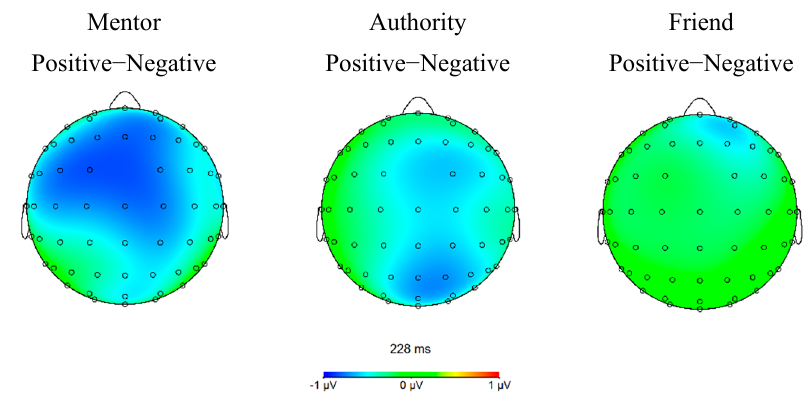
Figure 4. Topographical map of difference waves of N2 interaction.